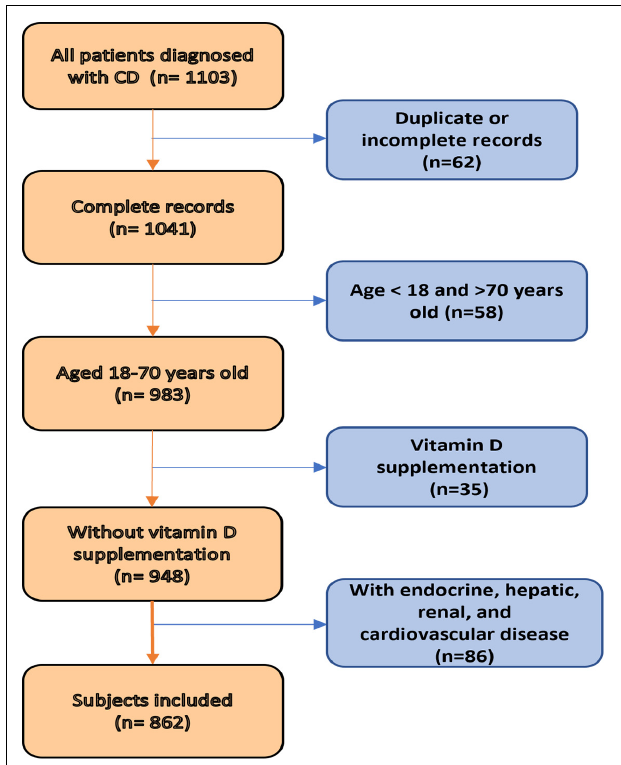
FIGURE 1 | Flowchart presenting the steps of inclusion and exclusion of